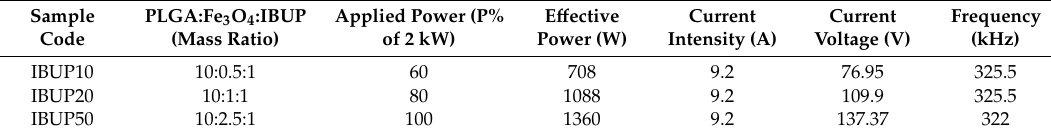
Table 1. Sample abbreviations and parameters used in hyperthermia